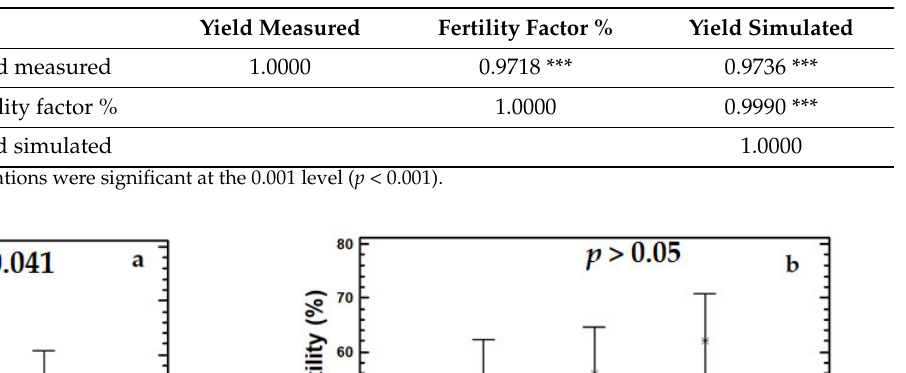
Table 10. Correlation coefficients matrix.